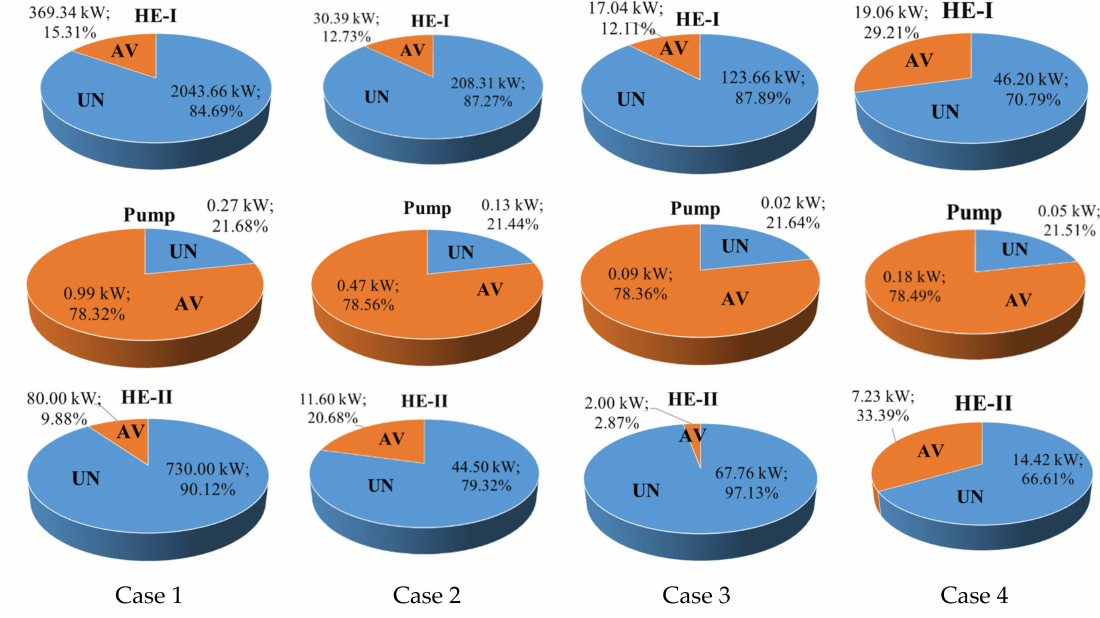
Figure 5. Advanced exergy assessment results respect to avoidable and unavoidable